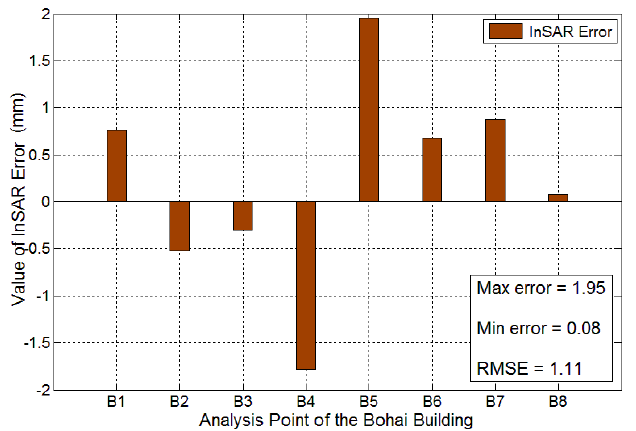
Figure 11. Measurement error between the extracted InSAR displacement and the truth leveling data in the Bohai Building, bigger column correspond to larger error.